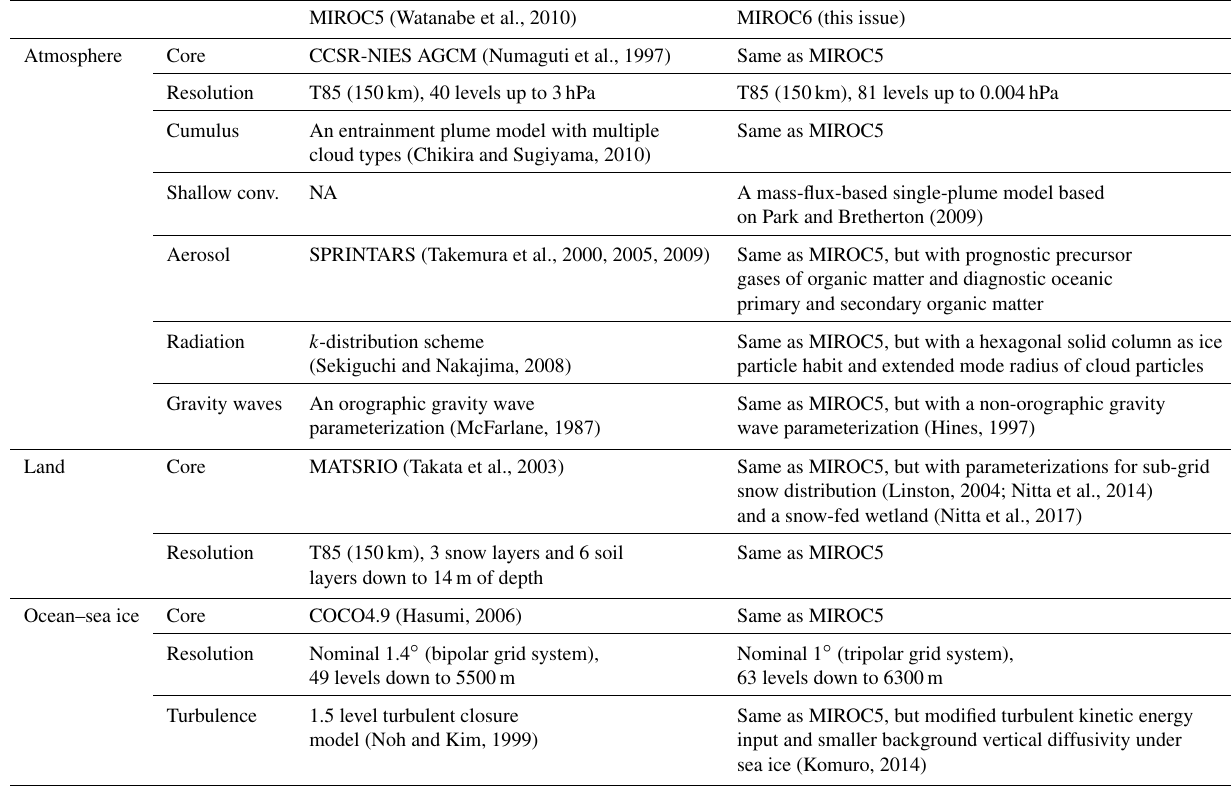
Table A1. Summary of the updated configurations from MIROC5 to